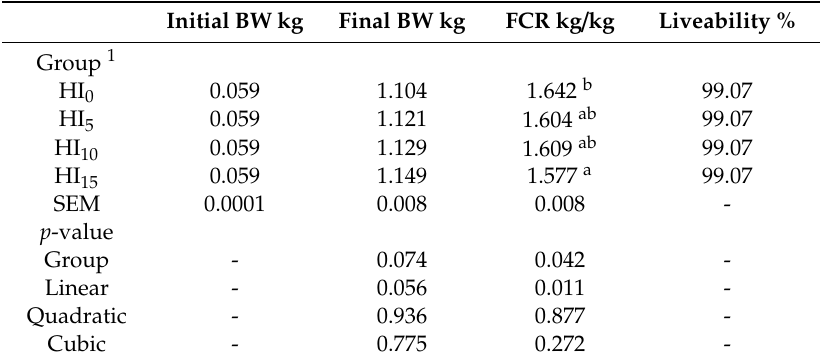
Table 3. Growth performance of turkeys (0–28